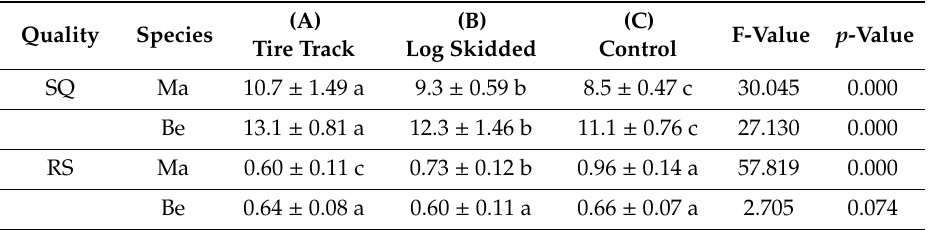
Table 4. Quality of maple (Ma) and beech (Be) seedlings on tire track, log skidded, and un-compacted (control) soils; and ANOVA and Duncan test